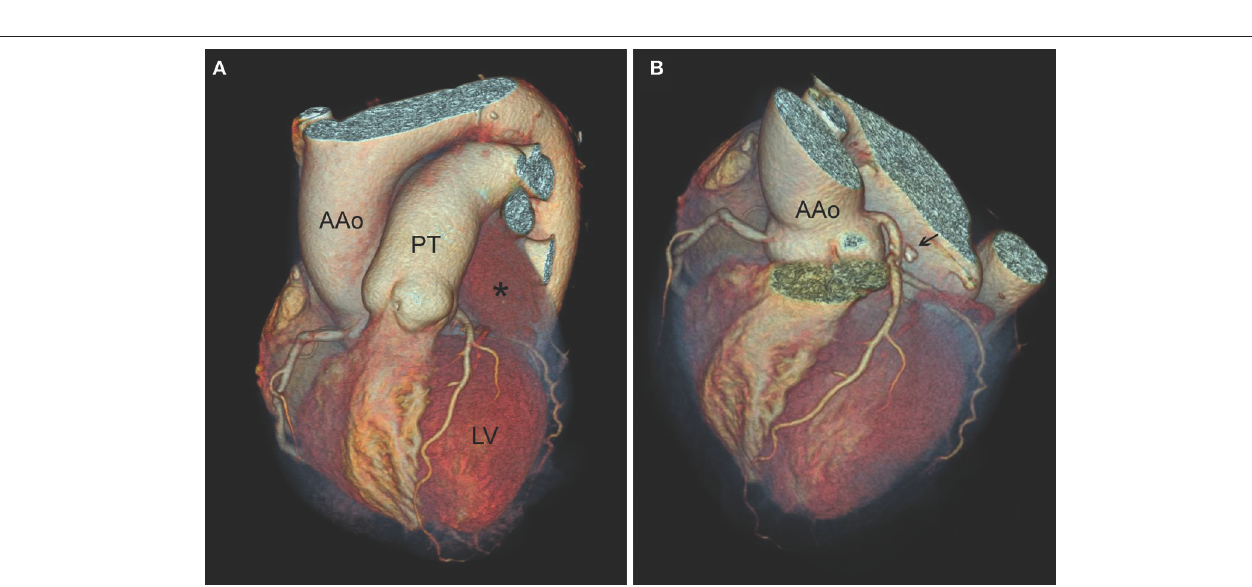
FIGURE 1 | Chest computed tomography. (A) Transverse section. The intrapericardial tumor (asterisk) lies between ascending aorta (AAo), pulmonary trunk (PT), and left pulmonary vein (LPV). It contains two macrocalcifications (white arrows) and is modeled by the left main coronary artery (black arrow). (B) Coronal section. Left atrium (LA) is slightly compressed by the tumor without any signs of invasion. Left ventricle (LV) models inferior part of the tumor, PT models its superior part.